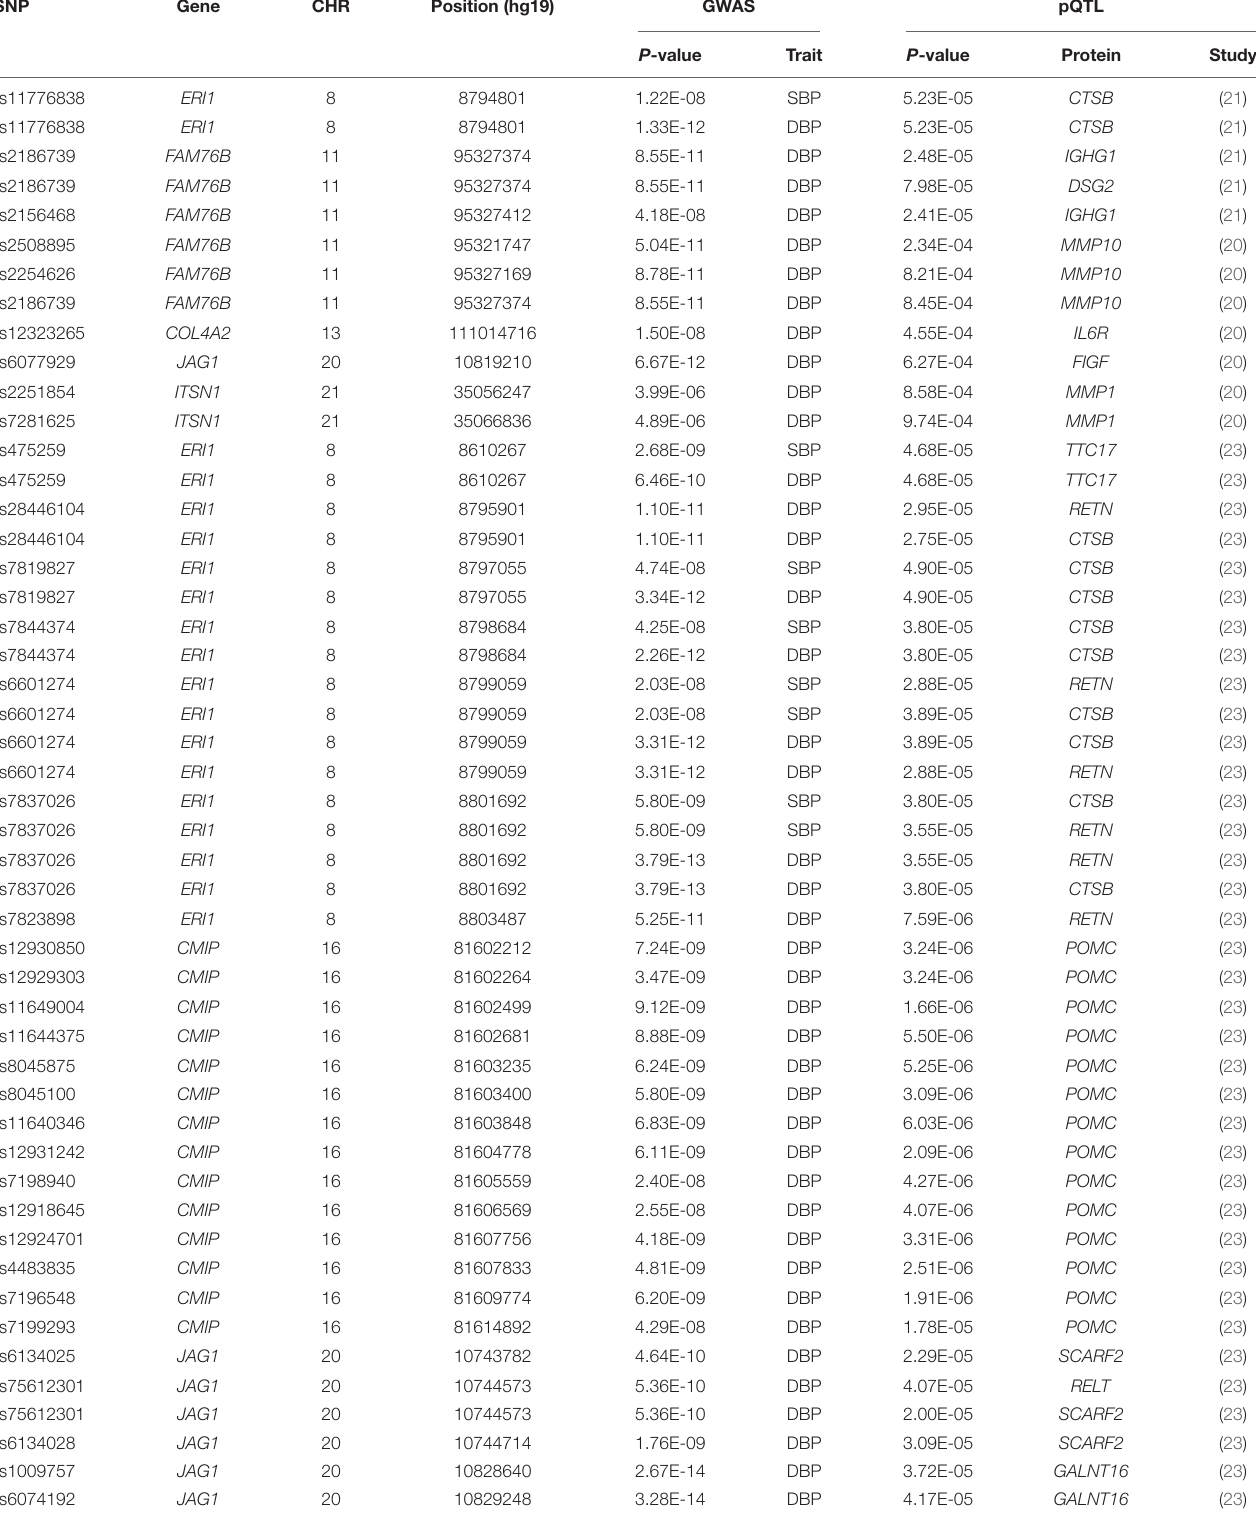
TABLE 2 | Proteins related to BP-associated